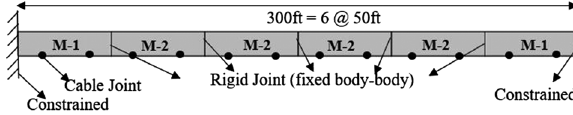
Fig. 2 Structural scheme of